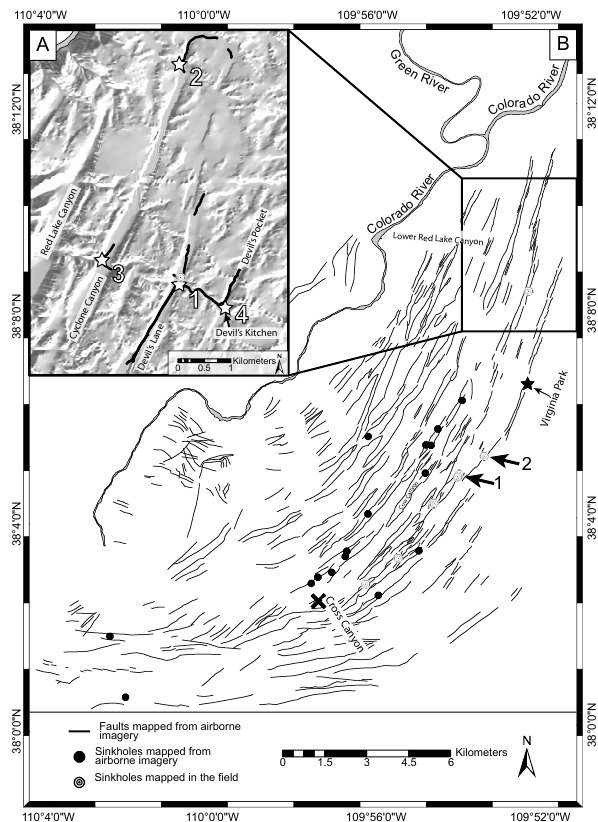
Figure 3. (a) Needles Area, northern part of the grabens as a hill- shade digital elevation model (National Elevation Dataset, NED). Presented GRP profiles indicated by numbered stars. Entire col- lected GPR data set is shown by black lines. (b) Overview of the Canyonlands grabens. Graben-bounding faults mapped via orthoim- agery. Sinkholes mapped in the field and from